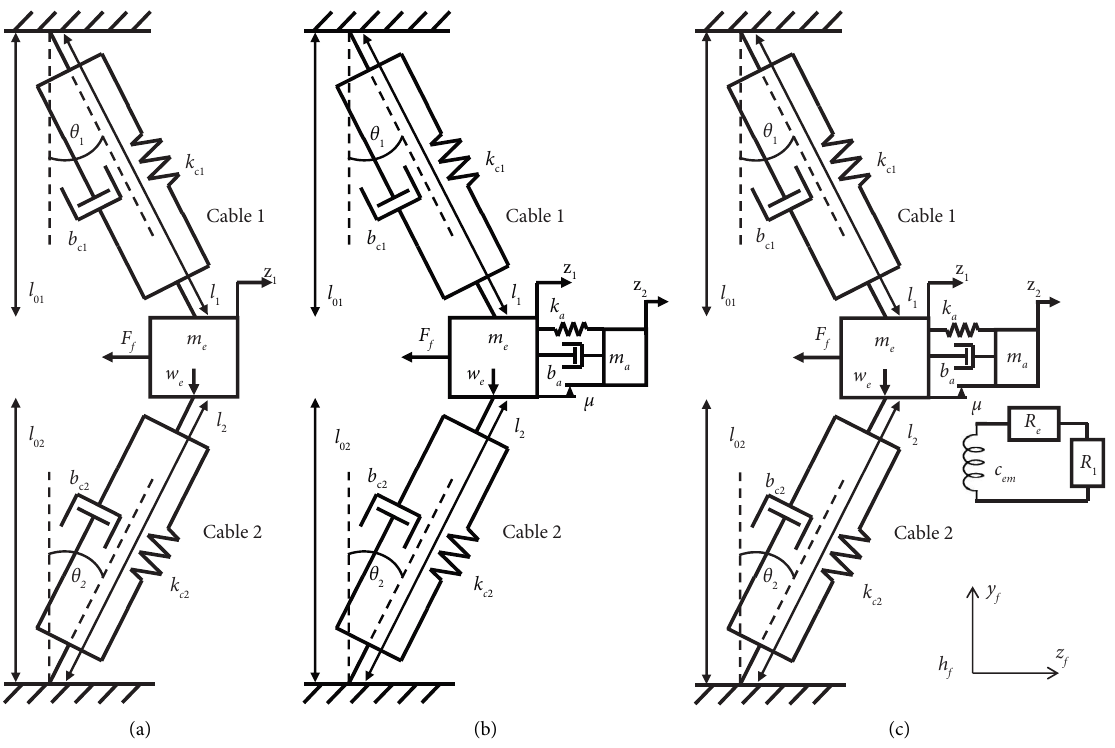
Figure 4: Dynamic diagrams of the three mathematical models. (a) Vibration without damper, (b) vibration with TMD, and (c) vibration with